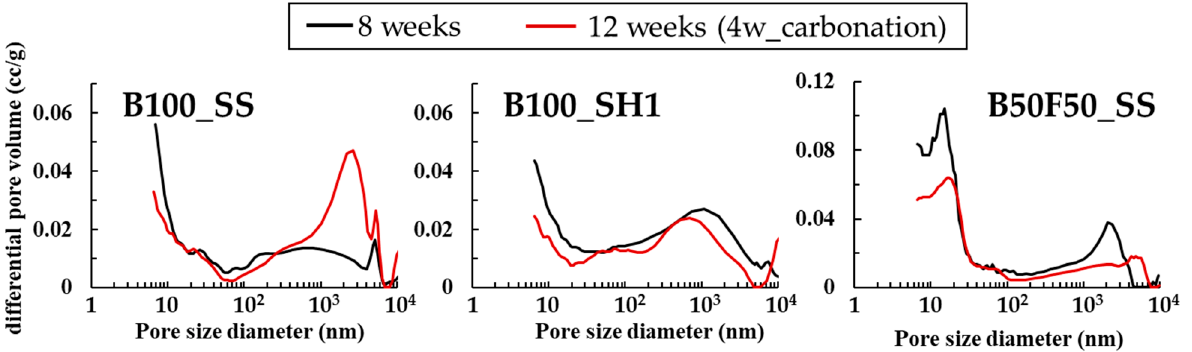
Figure 16. Pore structure analysis by MIP of 8 weeks, 12 weeks (accelerated carbonation 4 weeks).